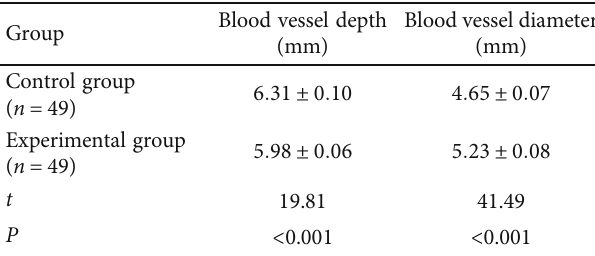
Table 3: Comparison of vascular depth and diameter under ultrasound between the two